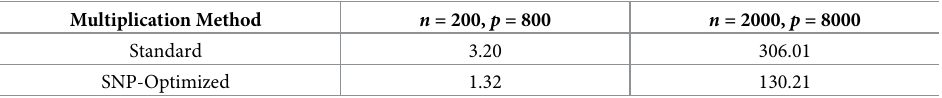
Table 4. Timing performance (milliseconds) on multiplication of SNP matrix and residual matrix. The methods are all implemented in C++ and run on a Macbook with 2.9 GHz Intel Core i7 and 8 GB 1600 MHz